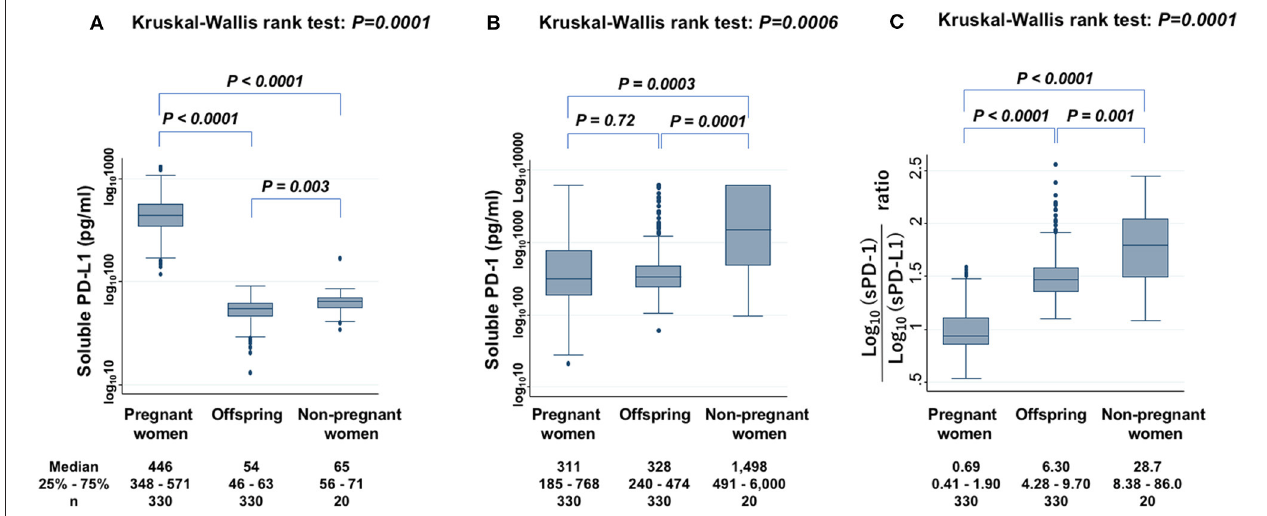
FIGURE 1 | Levels of sPD-L1 (A) , sPD-1 (B) , and the ratio of sPD-1 to sPD-L1 (C) in serum from PW, offspring, and non-PW controls. The Kruskal-Wallis rank test (KW test) was used for comparisons among three groups. The Mann-Whitney test was used to compare two groups. Values were transformed by the common logarithm (log 10 ) prior to analysis and are shown in the graph, although the median and 25 − 75th percentiles are presented as absolute values.